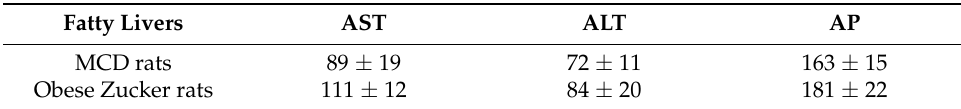
Table 1. Serum hepatic enzymes before liver procurement: aspartate aminotransferase (AST), alanine aminotransferase (ALT) and alkaline phosphatase (AP).